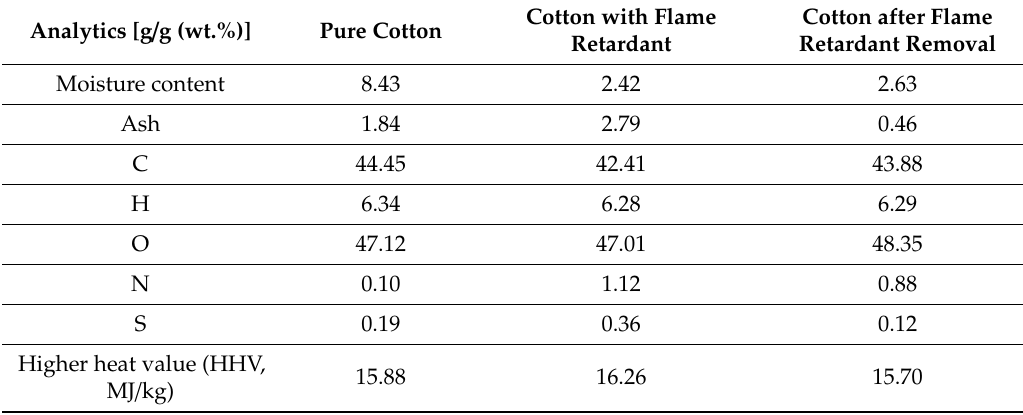
Cotton with Flame Cotton after Flame Retardant Retardant Removal